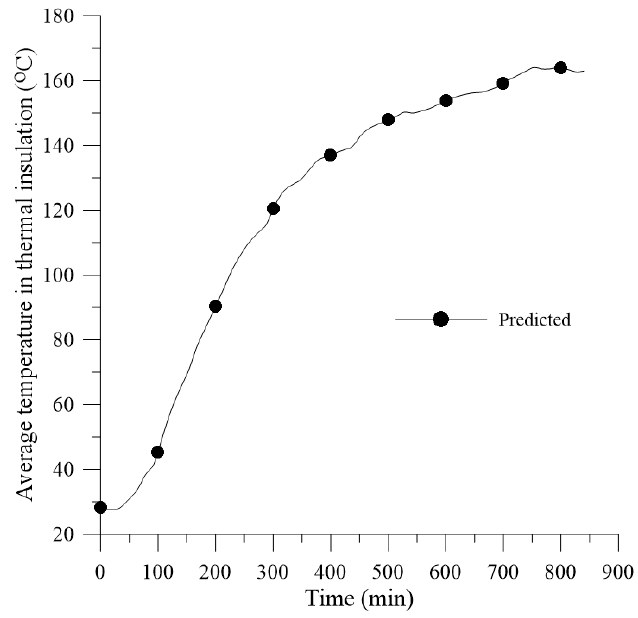
Figure 22. Average temperature inside the thermal insulation during the heating process.